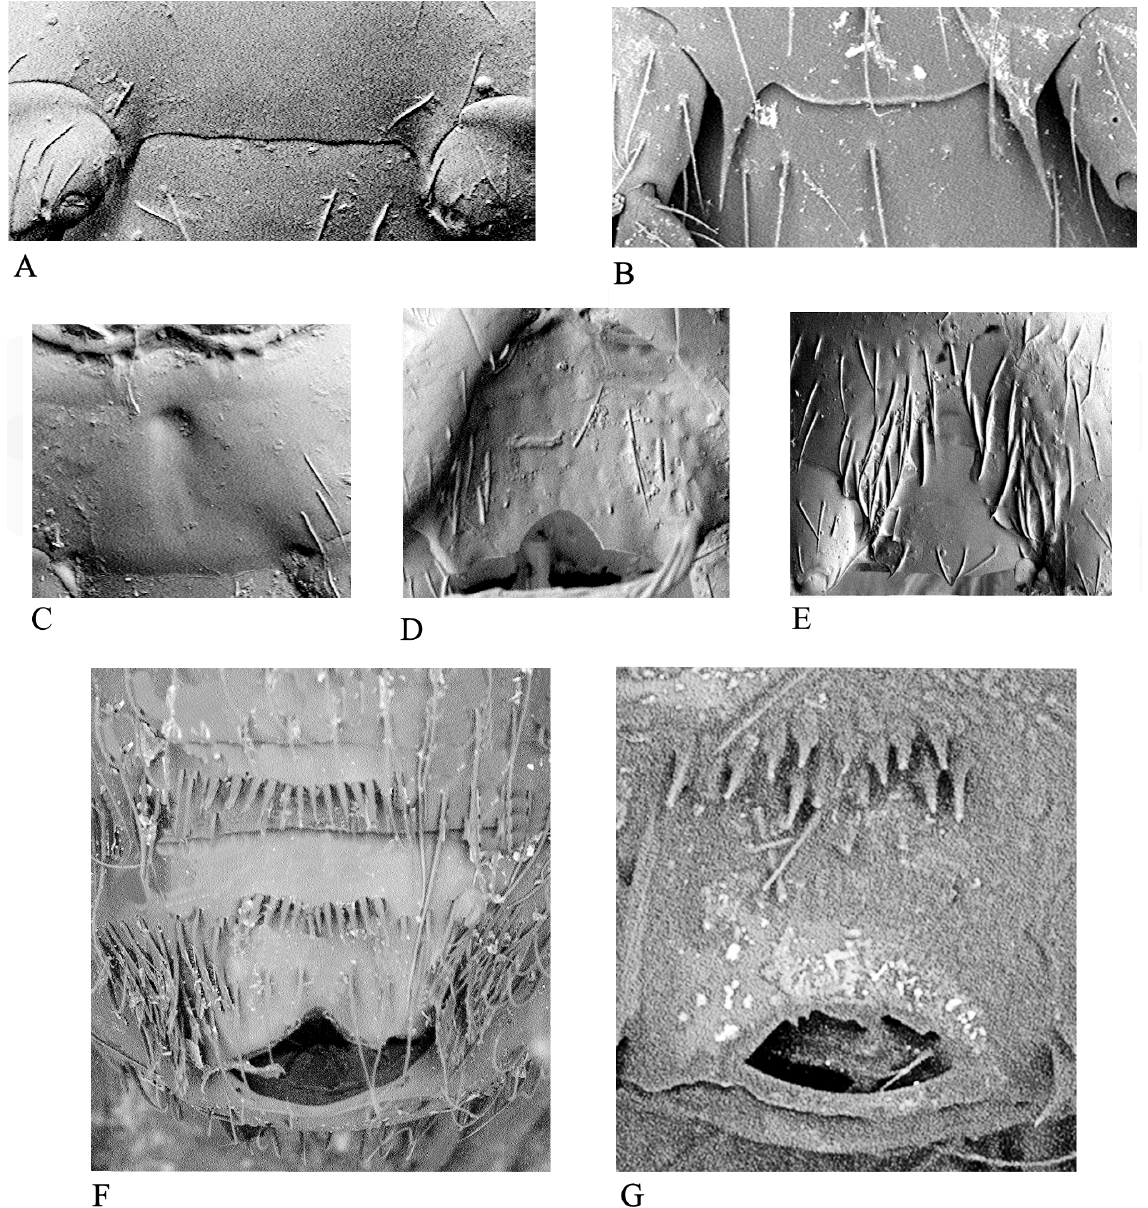
Fig. 7. Metaventral and male ventrite examples. A–B . Metaventrite posterior margin to show